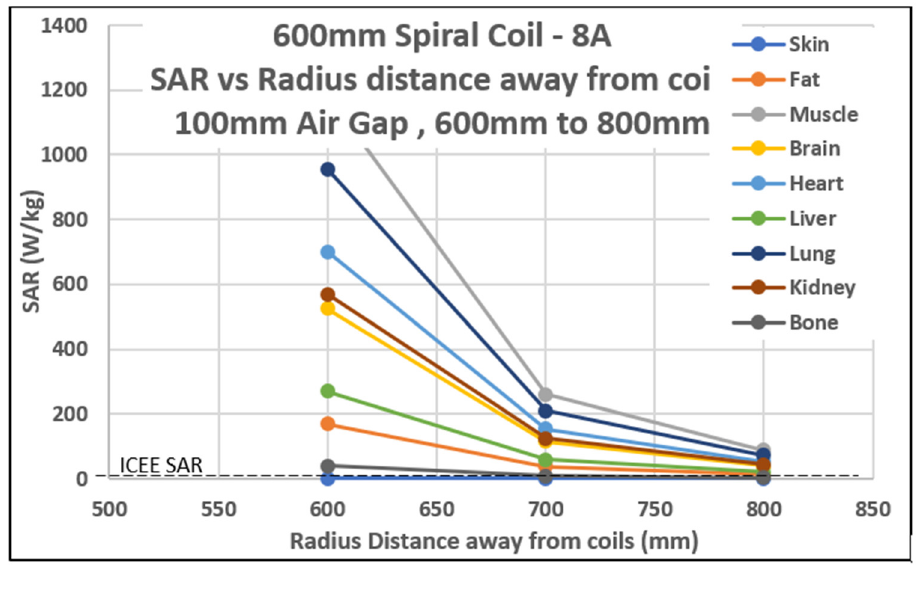
Figure 12. Magnetic field exposure rates vs. radial distance away from coils: ( a ) 120 mm spiral coil. ( b ) 120 mm square coil. ( c ) 600 mm spiral coil excited with 1 A of current. ( d ) 600 mm spiral coil excited by 8 A of current.